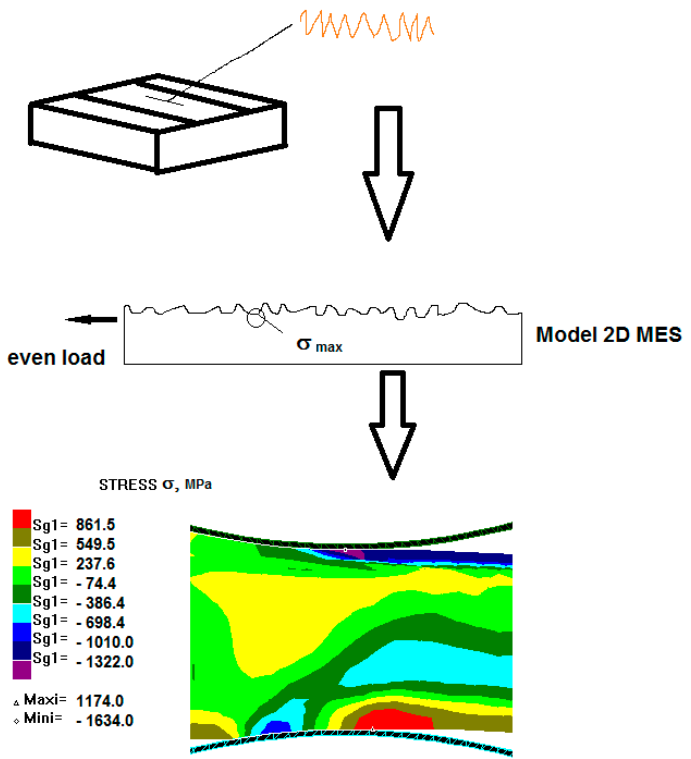
Figure 9. The principle of numerical calculations of stress concentration.